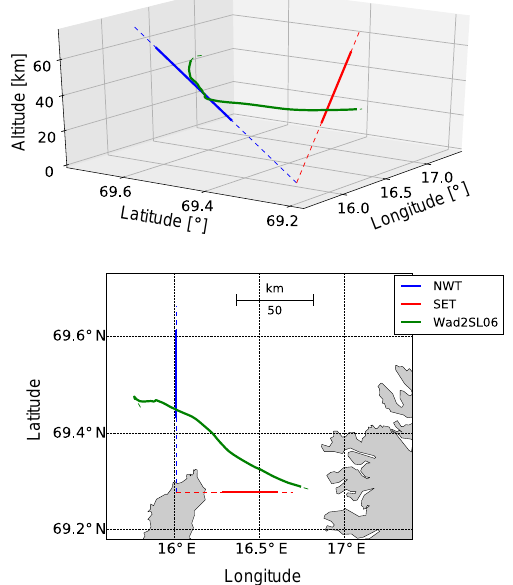
Figure 2. Trajectory of datasonde flight SL6 (green) and lidar beams for the NWT (blue) and SET (red) telescopes, respectively. Thick lines represent the altitude range of 30–65km.